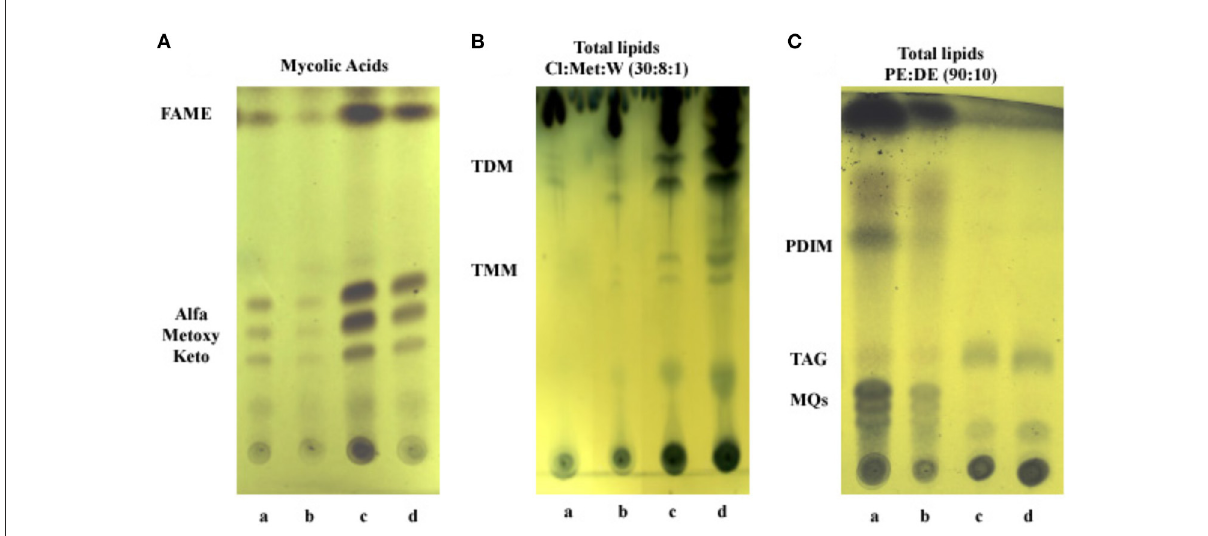
FIGURE7 Analysis of lipid content by thin layer chromatography. (A) Mycolic acids. FAME, fatty acids methyl esters. (B) Polar lipids: TDM, trehalose dimycolate; TMM, trehalose monomycolate; Cl, chloroform; Met, methanol; W, water. (C) Apolar lipids: PDIM, phthiocerol dymycocerosate; TAG, triacylglycerol; MQs, menaquinones; PE, petroleum ether; DE, diethyl ether. Lanes: a, Exp5–Fe; b, Exp5 + Fe; c, Stat6–Fe; and d, Stat6 +